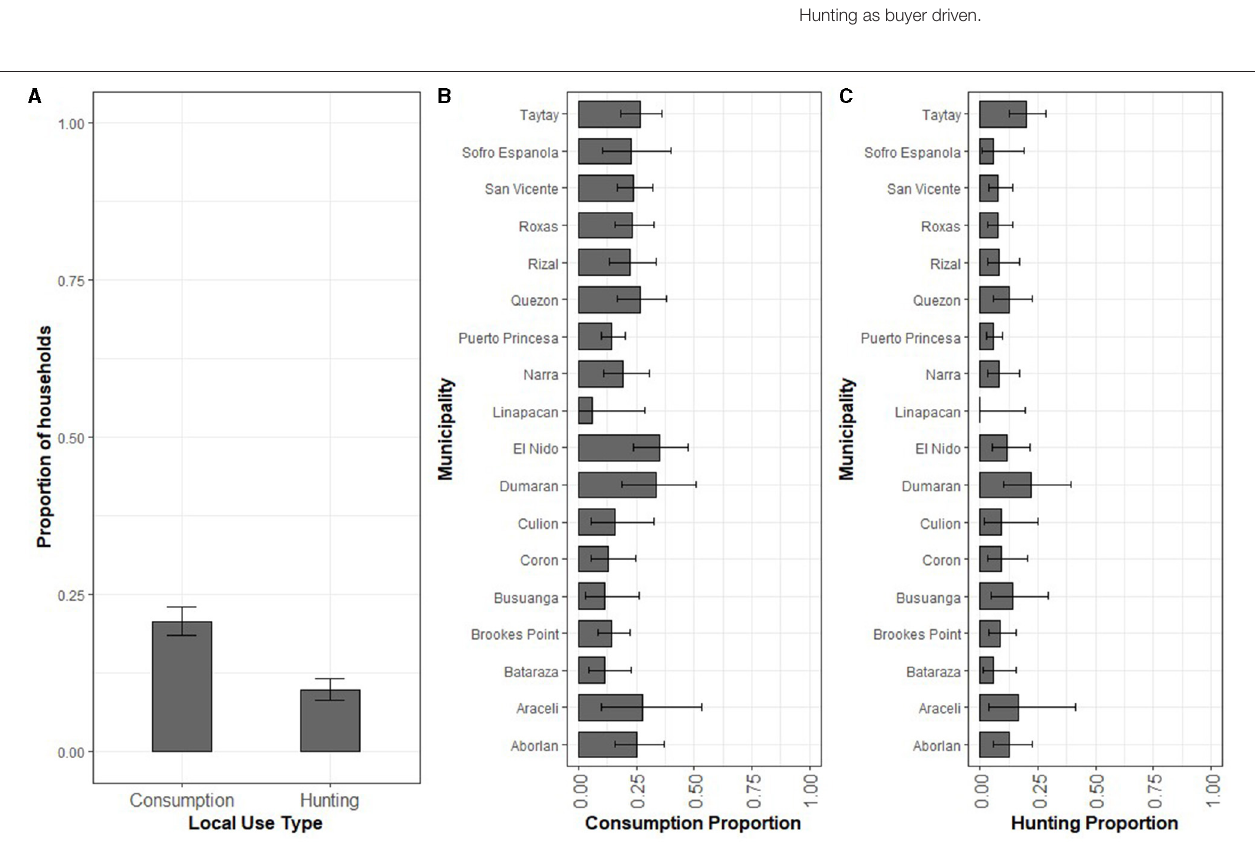
FIGURE 2 | (A) Total proportion of households reporting local use of pangolins; (B) proportion of households per municipality who reported consuming pangolins; (C) proportion of households per municipality who reported hunting pangolins. Error bars show 95% confidence